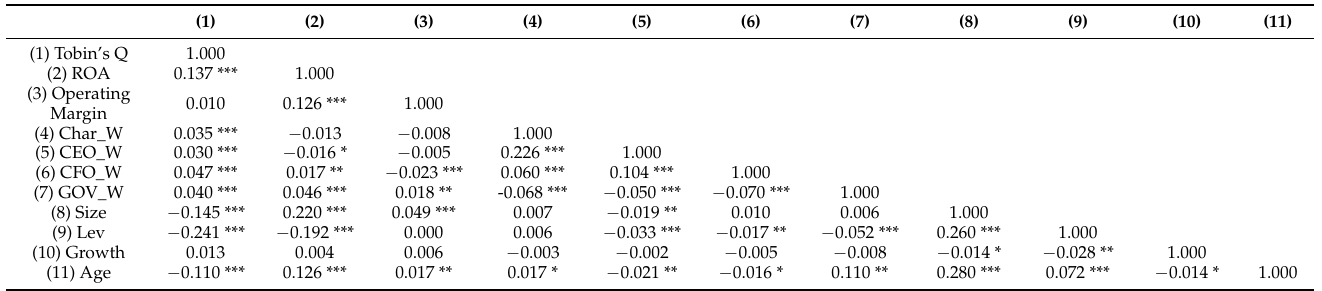
Table 4. Pearson’s correlation